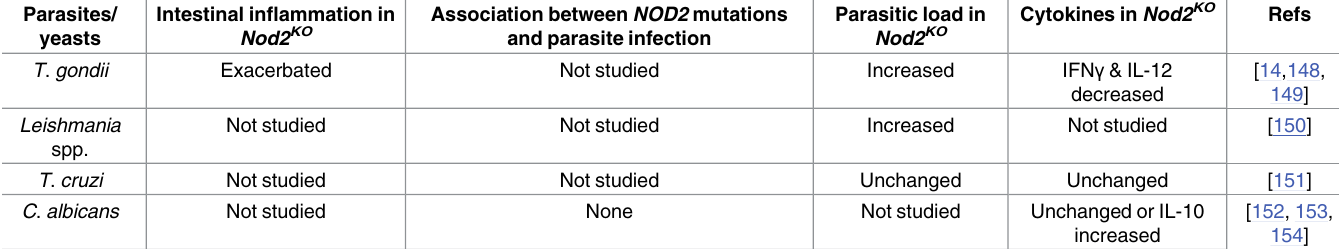
Table 3. Role of Nod2 in the host response toward parasitesand